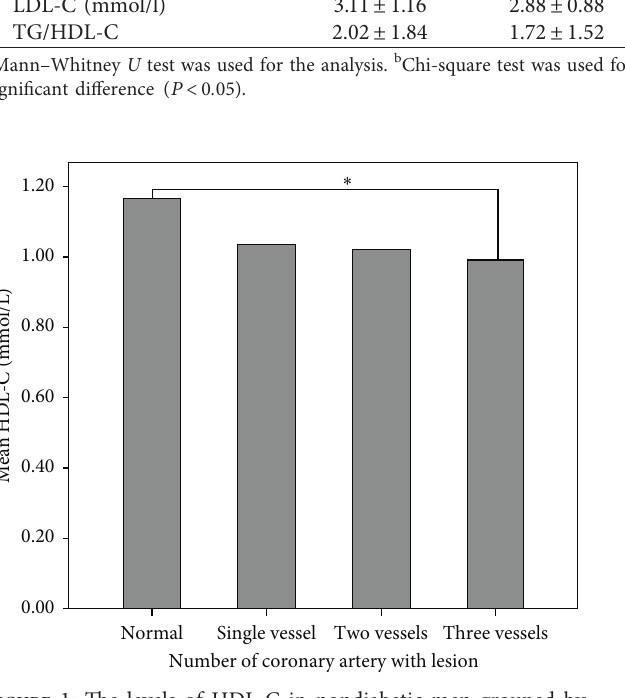
Figure 1: The levels of HDL-C in nondiabetic men grouped by different numbers of coronary artery with lesion ( P < 0 . 05 ) (one- way ANOVA was used for the analysis, and ∗ denotes further multiple comparisons: normal vs . three vessels ( P < 0 . 05 )